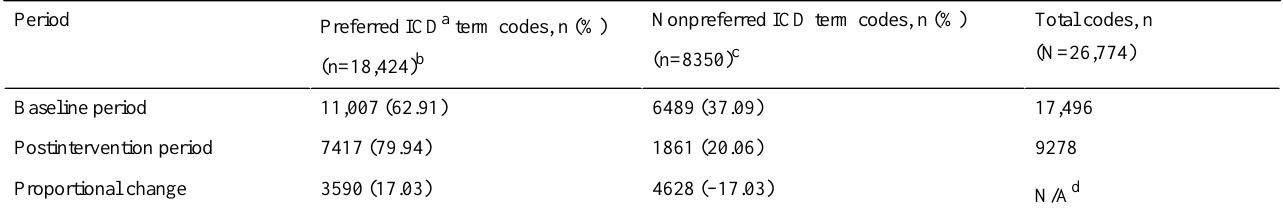
Table 1. Proportion of preferred International Classification of Diseases, 9th Revision codes used in the baseline and intervention